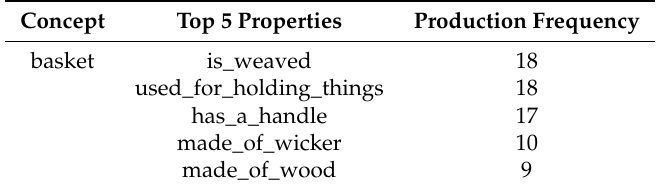
Table 2. Top 5 properties for the concept basket in McRae and their production